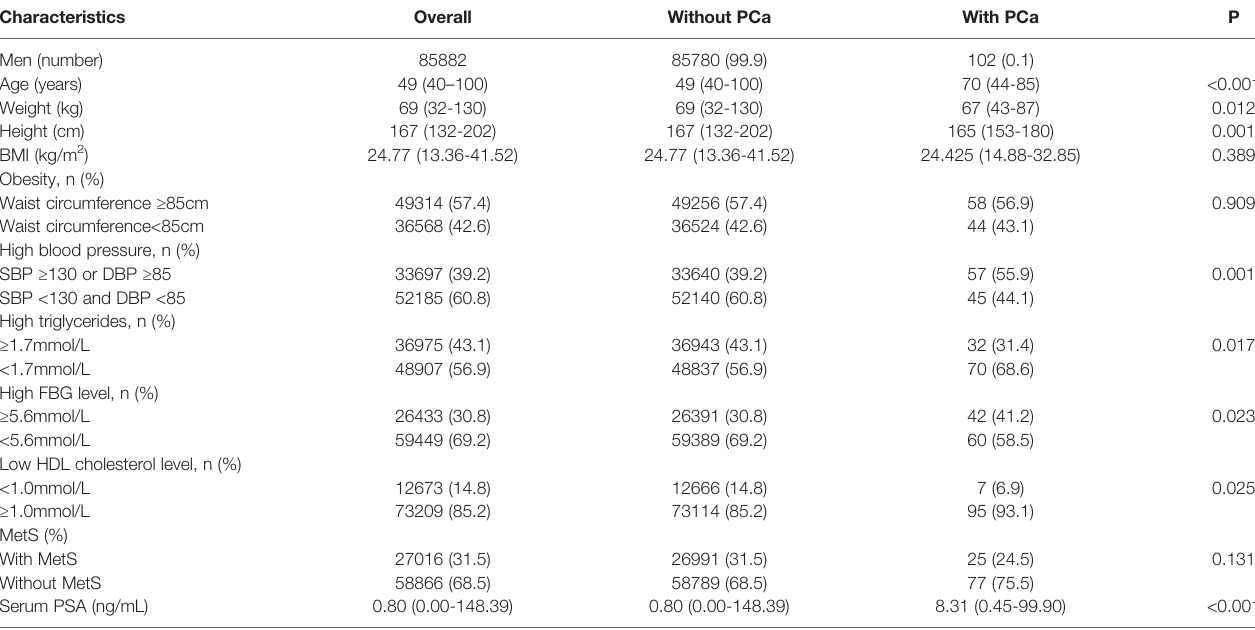
TABLE 1 | Baseline characteristics of patients according to the diagnosis of